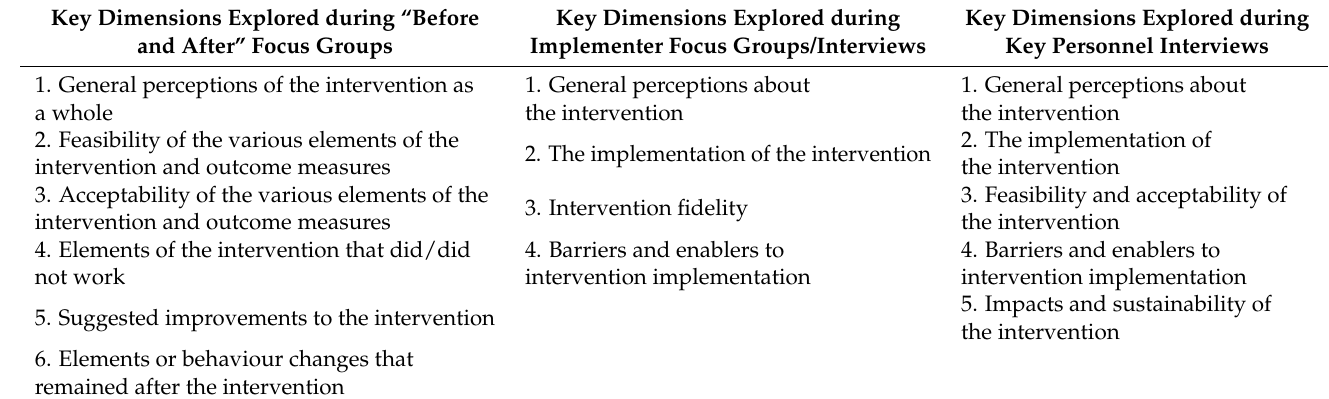
Table 1. Key dimensions explored during focus groups and